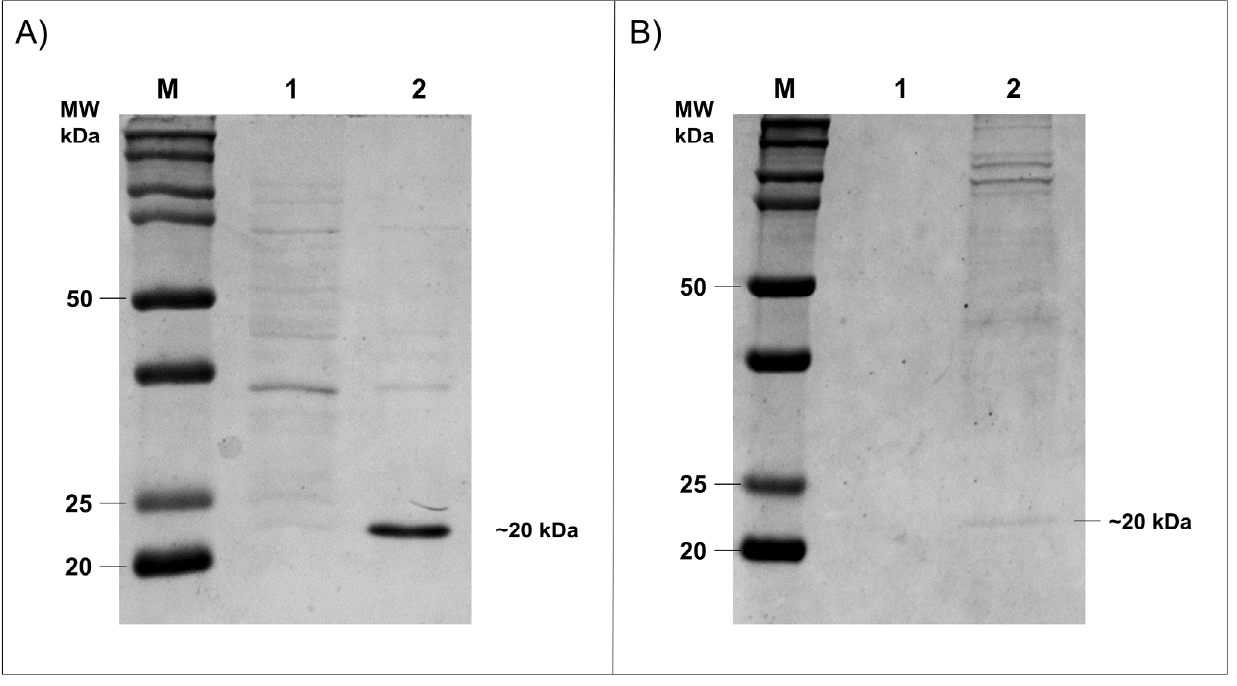
Figure 4. Expression of HtpXyl in bacteria and yeast observed in 12% SDS-PAGE gel. ( A ) HtpXyl